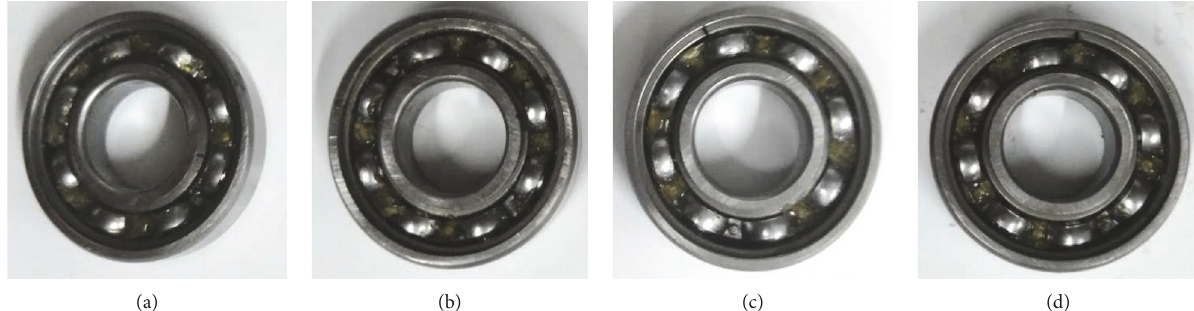
Figure 7: Real faulty bearings. (a) Inner race fault 0.1mm. (b) Inner race fault 0.3mm. (c) Outer race fault 0.1mm. (d) Outer race fault 0.3mm.